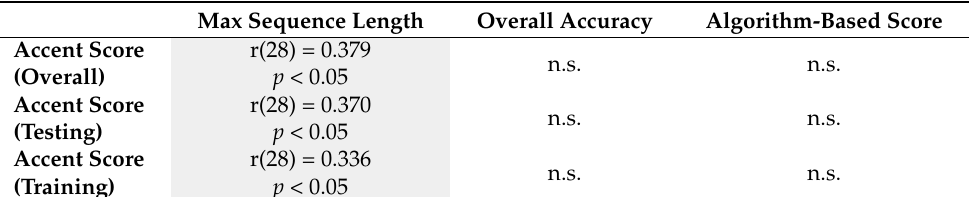
Table 2. Significant correlations between variables associated with phonetic and phonological learning (arranged vertically) and variables associated with auditory sensory memory (arranged horizontally) for the MONOLINGUAL group. Gray shading indicates the strength of the correlation (light gray = weak correlation, medium gray = moderate correlation, dark gray = strong correlation); n.s. = not